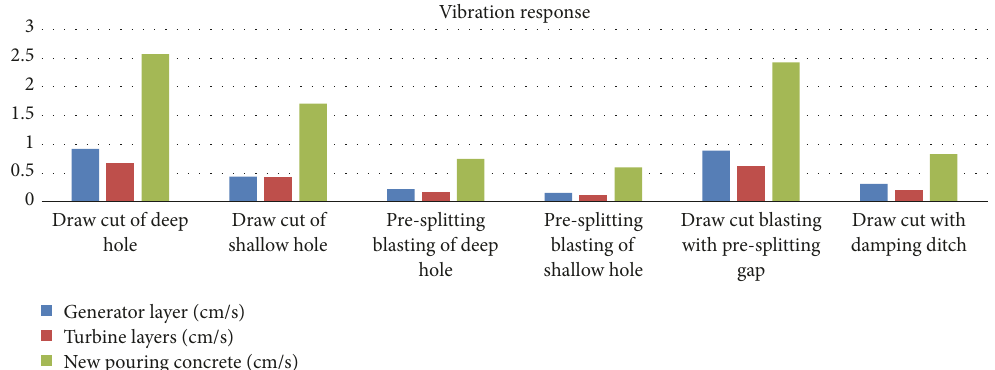
Figure 9: Comparison of vibration response for different blasting excavation methods in the critical control points.